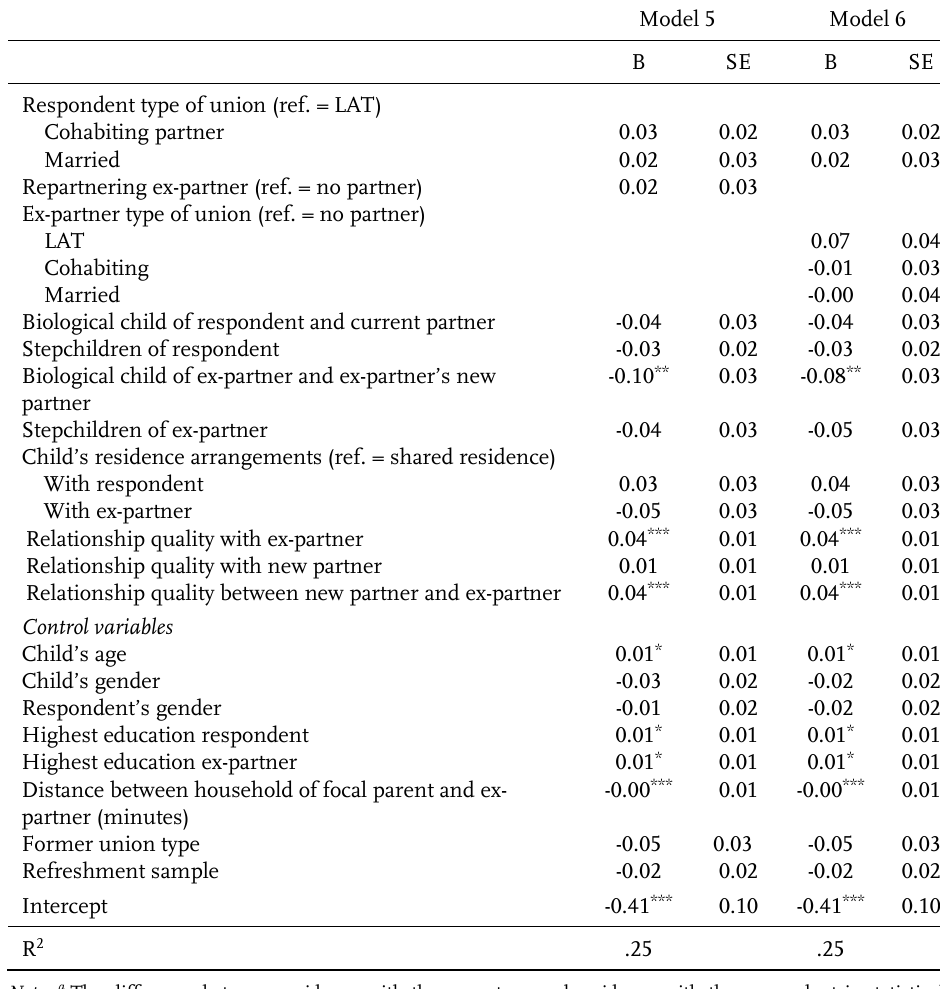
Table 4: Summary of linear probability models predicting the ex-partner's and current partner's joint attendance at the child’s last birthday